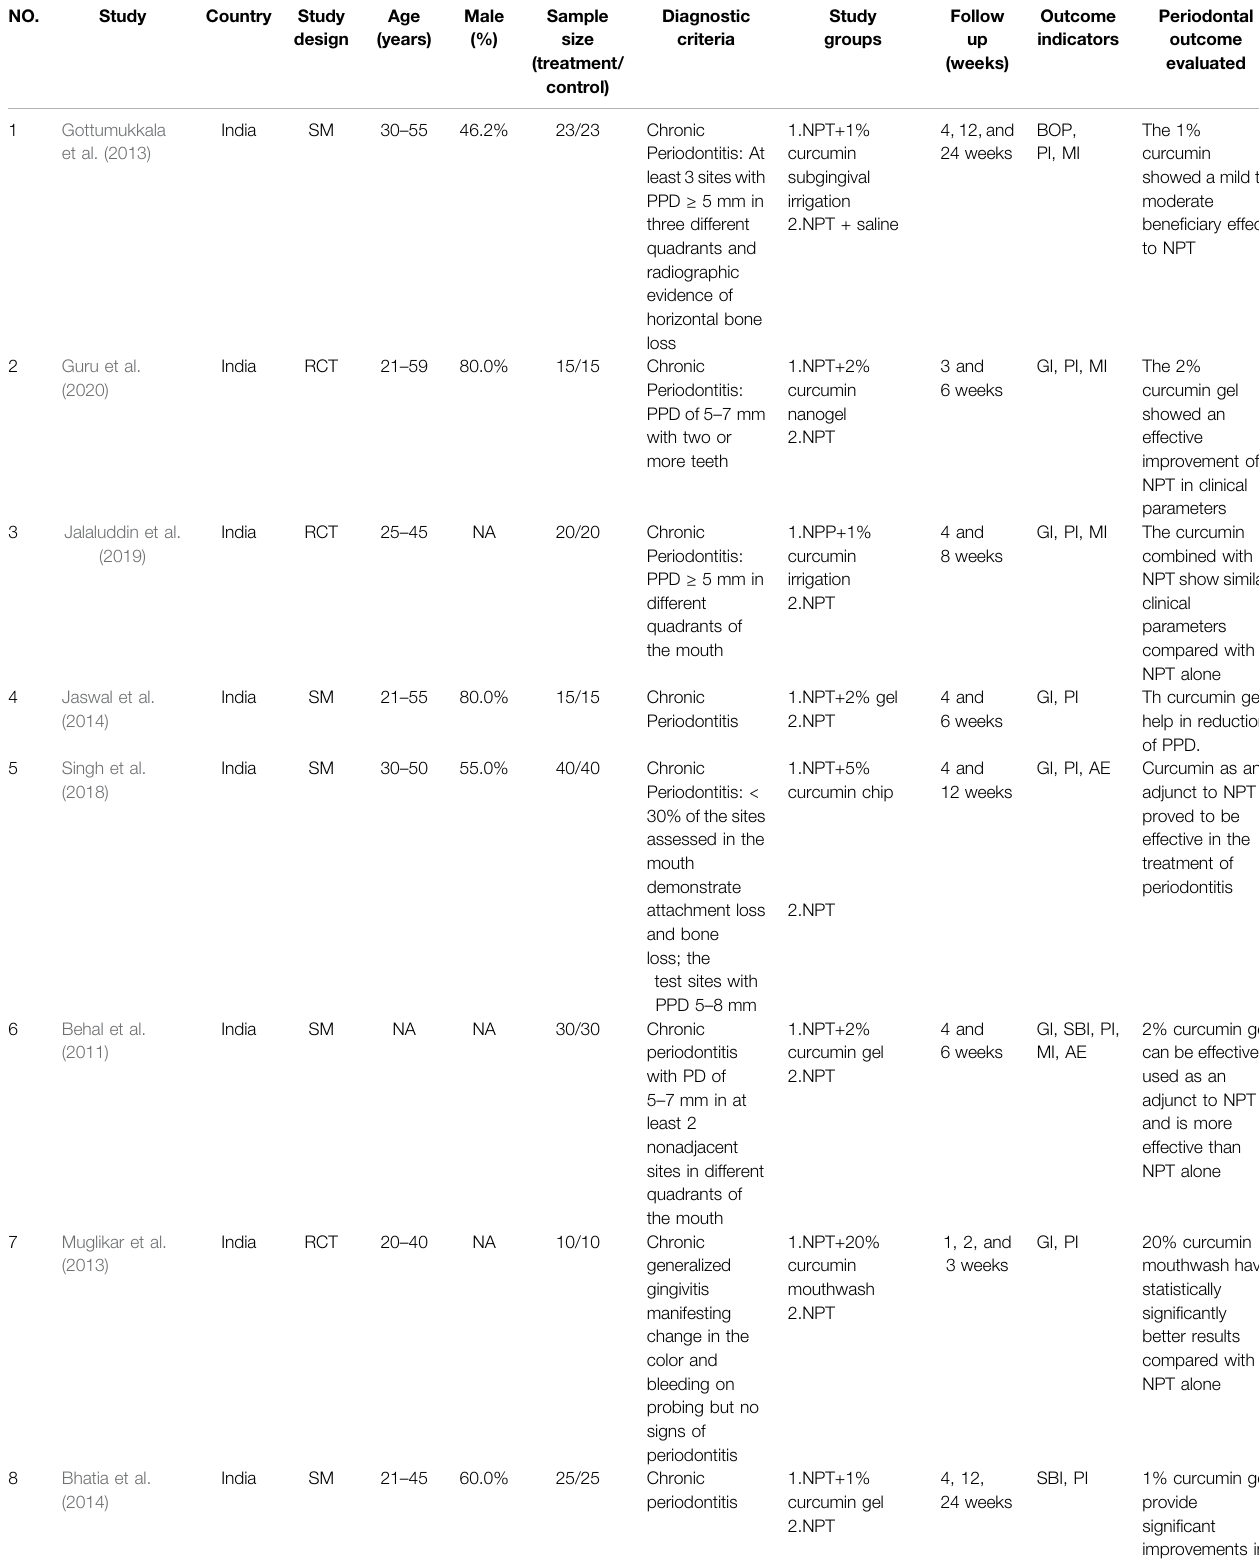
TABLE 1 | Basic characteristics of included